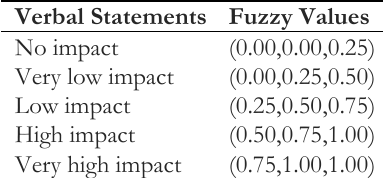
Table 1. Verbal statements used in this study and their equivalent fuzzy values.